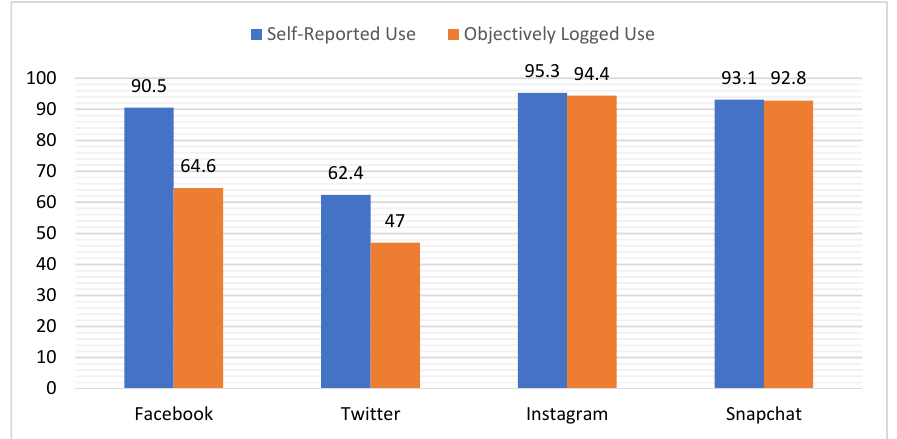
Figure 1. Percentages of the sample self-reporting versus logging active use of each SM.